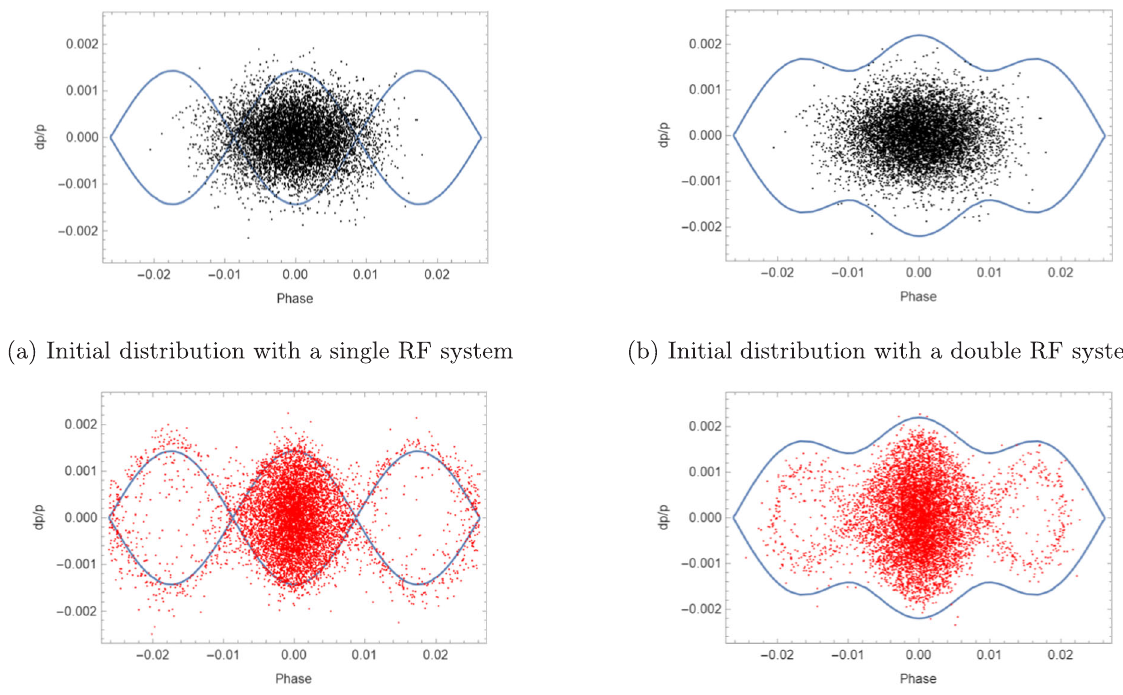
FIG. 8. Longitudinal phase space distribution for a single rf system (28 MHz) and a double rf system (28 and 9 MHz), before and after 7000 turns. The double rf system (b) provides a larger central bucket area than the single rf system (a). Debunched beam after 7000 turns is negligible in the double rf case (d), compared to the single rf case